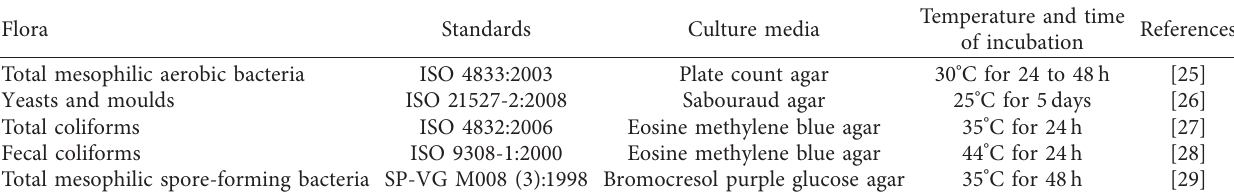
Table 2: Flora, norms, culture media, and incubation conditions used for microbiological